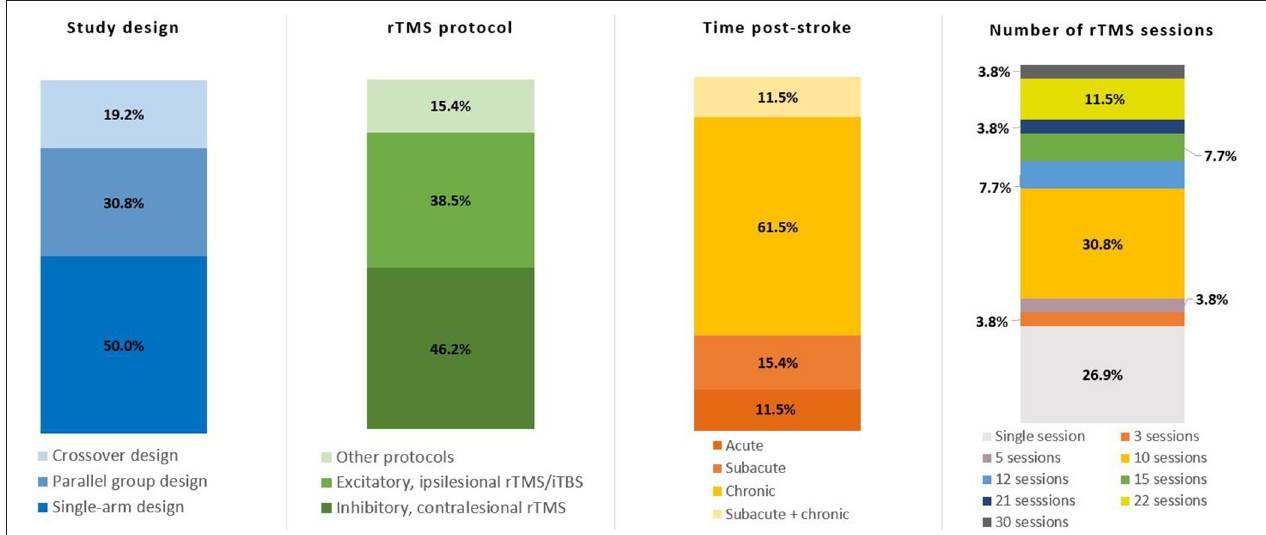
FIGURE 3 | Key details of included studies. Total number of studies n = 26. rTMS, repetitive transcranial magnetic stimulation; iTBS, intermittent theta burst